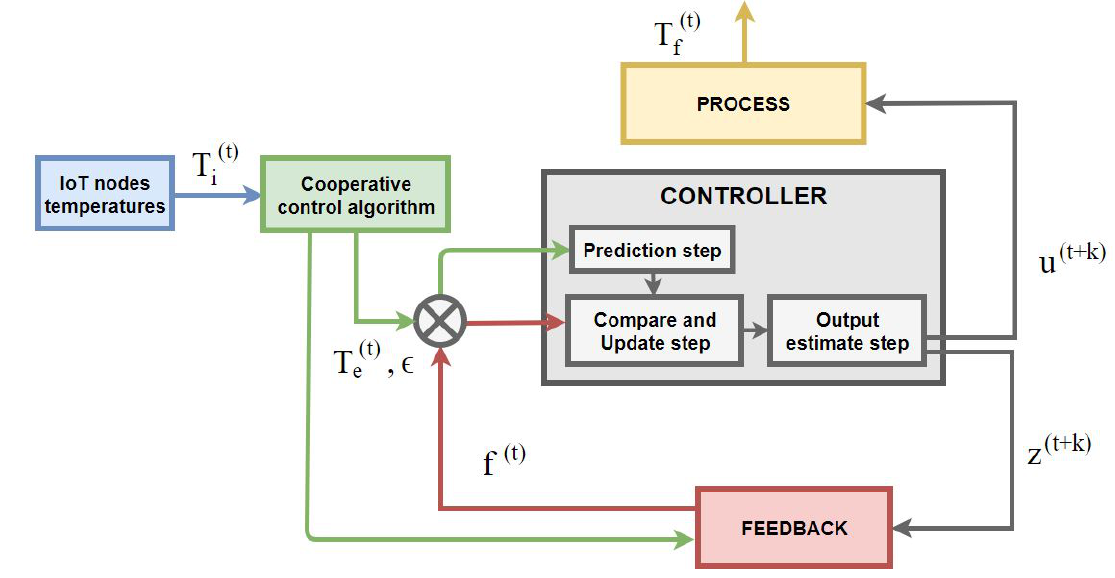
Figure 1. This algorithm improves the fault tolerance of the IoT network via the designed control algorithm in the time interval ( t , t + k ) , where k is the interval of time that we want to